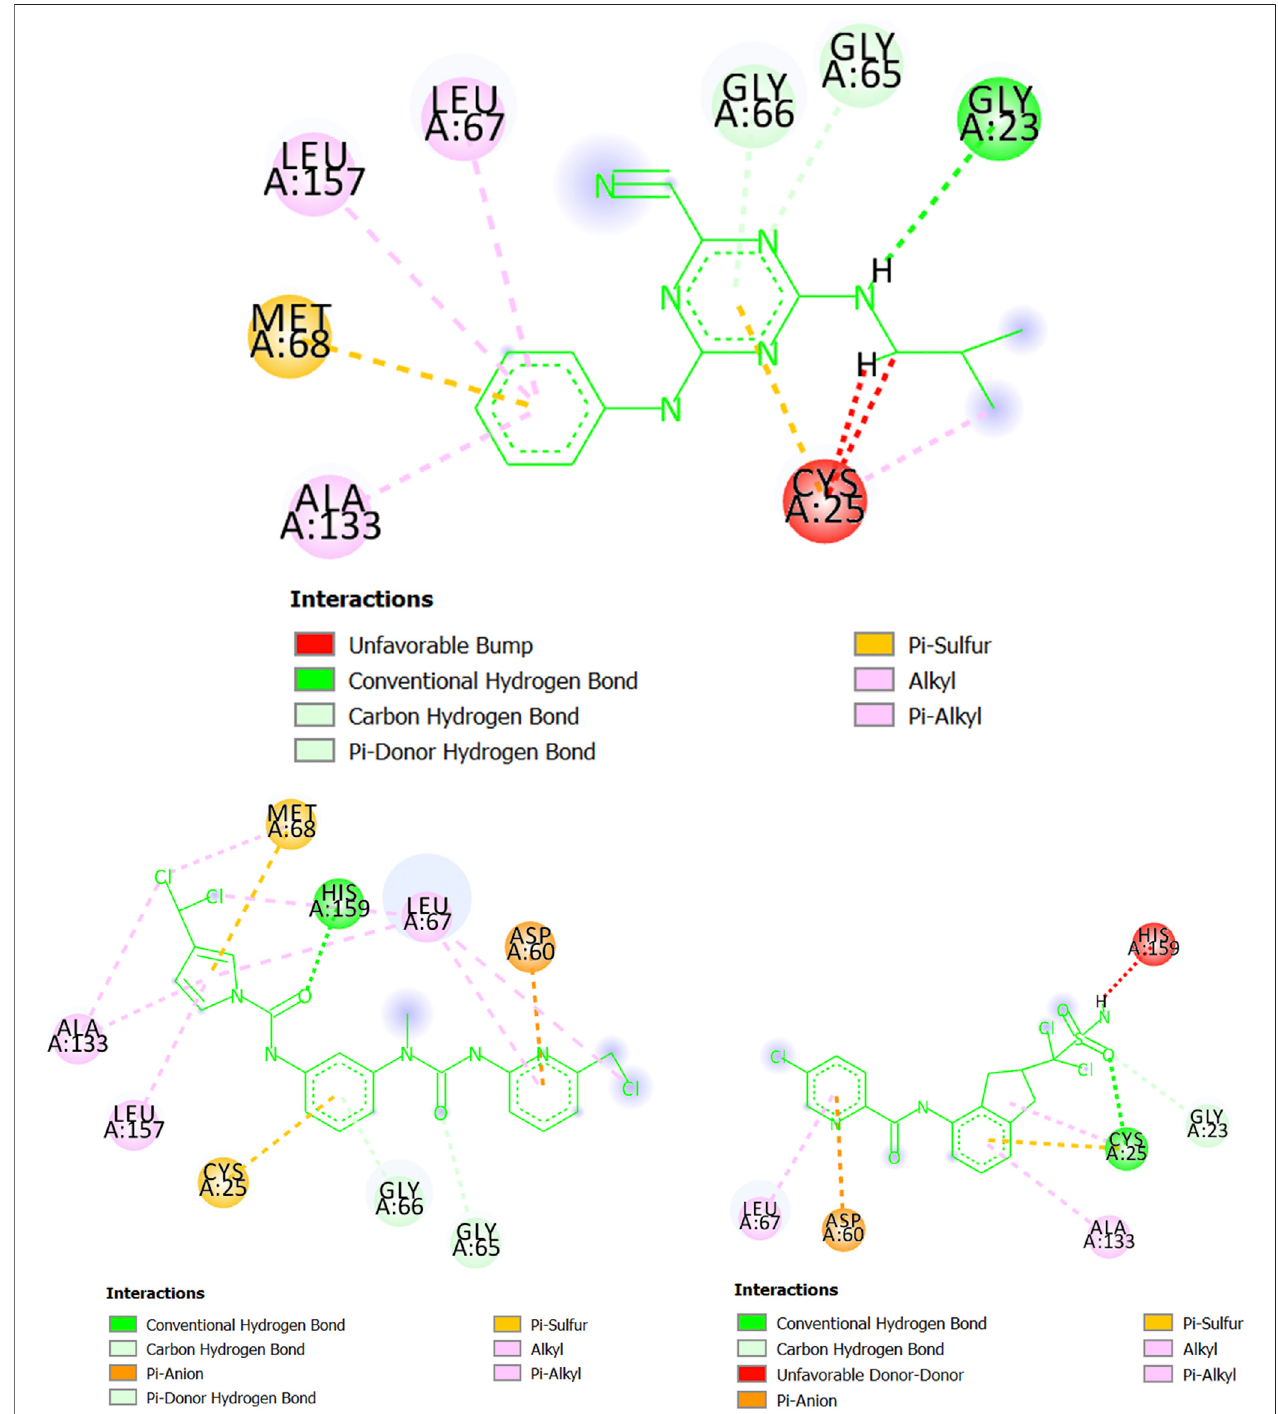
FIGURE 8 | Interactions of CHEMBL565866 (top center) , MTIPP-002 (left bottom) and MTIPP-004 (right bottom) with cruzipain ( T. cruzi ).